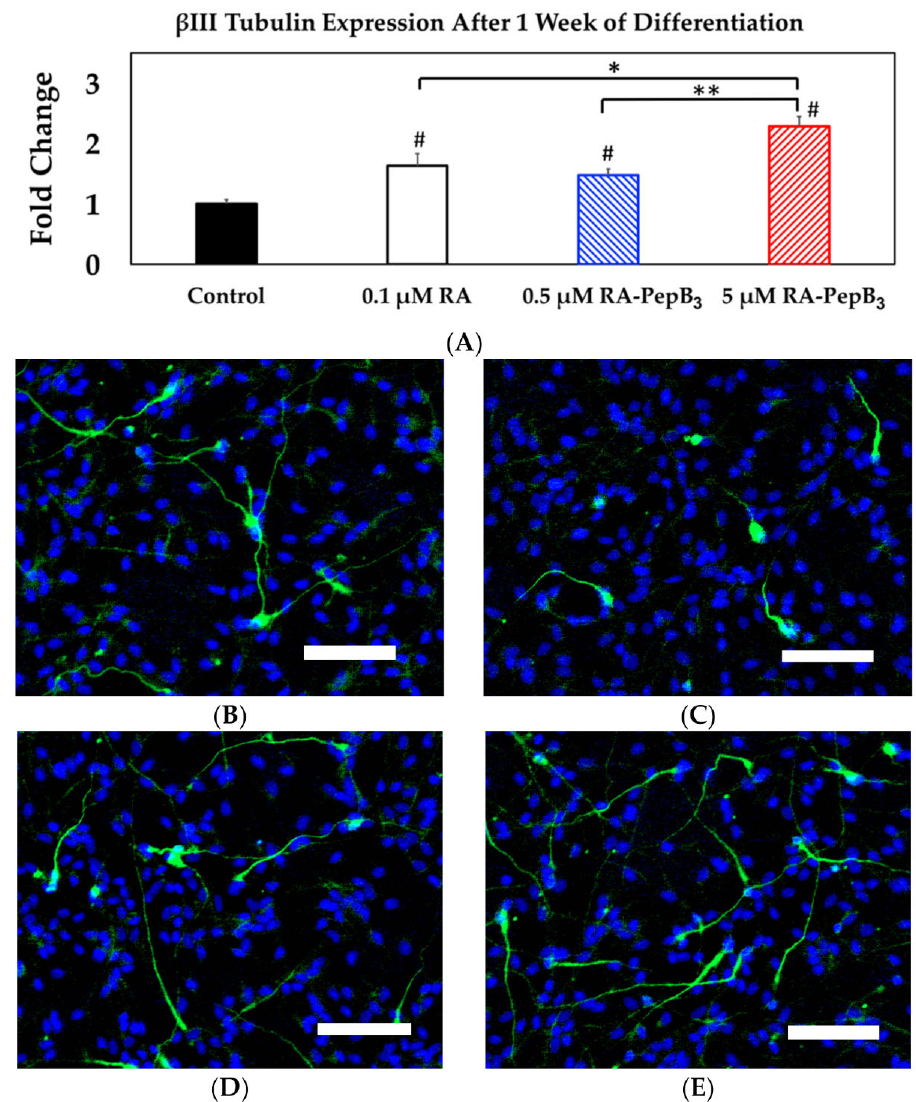
Figure 12. Short-term high-concentration RVM differentiation results. ( A ) Comparison of β -III tubulin levels in one week differentiated RVM. Fluorescence microscopy images of ReNcell VM after one week of differentiation were taken for ( B ) control, ( C ) 0.1 µ M RA, ( D ) 0.5 µ M RA-PepB 3 , and ( E ) 5 µ M RA-PepB 3 . The cells were stained for nuclei (DAPI; blue) and β -III tubulin (green). Control group cells were differentiated by growth factor withdrawal only (no additional compounds). N = 3; error bars depicted as SEM; Student's t -test, * p < 0.05, ** p < 0.01, # p < 0.001 compared with control; scale bar = 100 µ